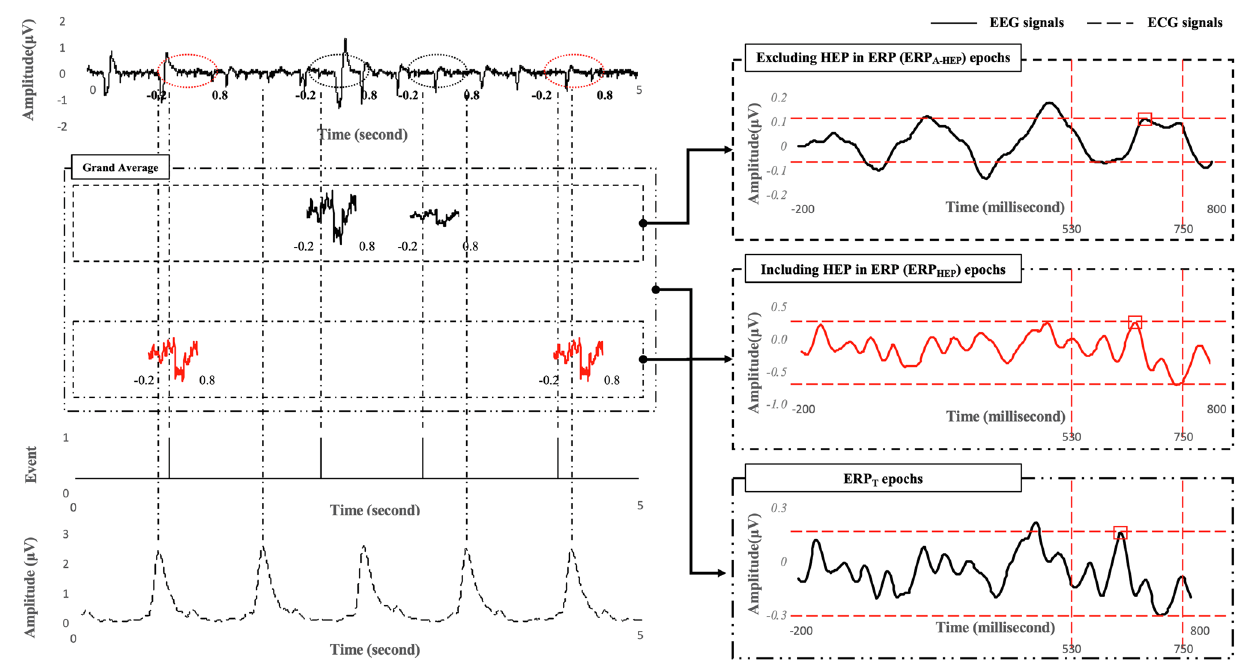
FIGURE 4 | Examples of signal processing compared across ERP A-HEP , ERP HEP , and ERP T